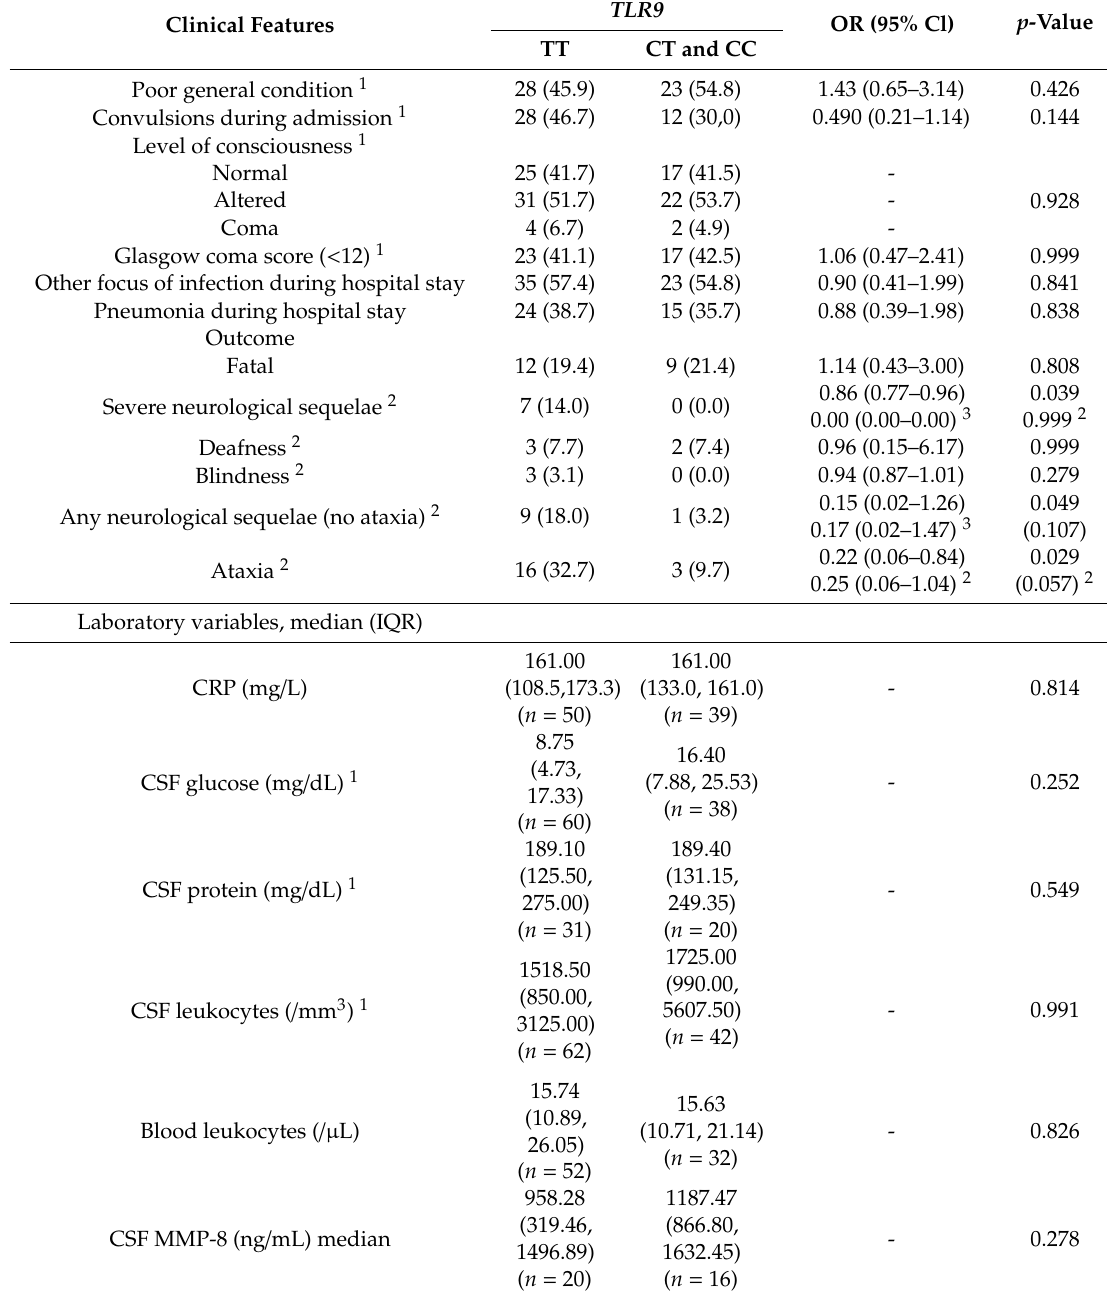
Table 5. Associations between the TLR9 (rs187084) polymorphism and the laboratory values and severity factors of Gram-negative bacterial